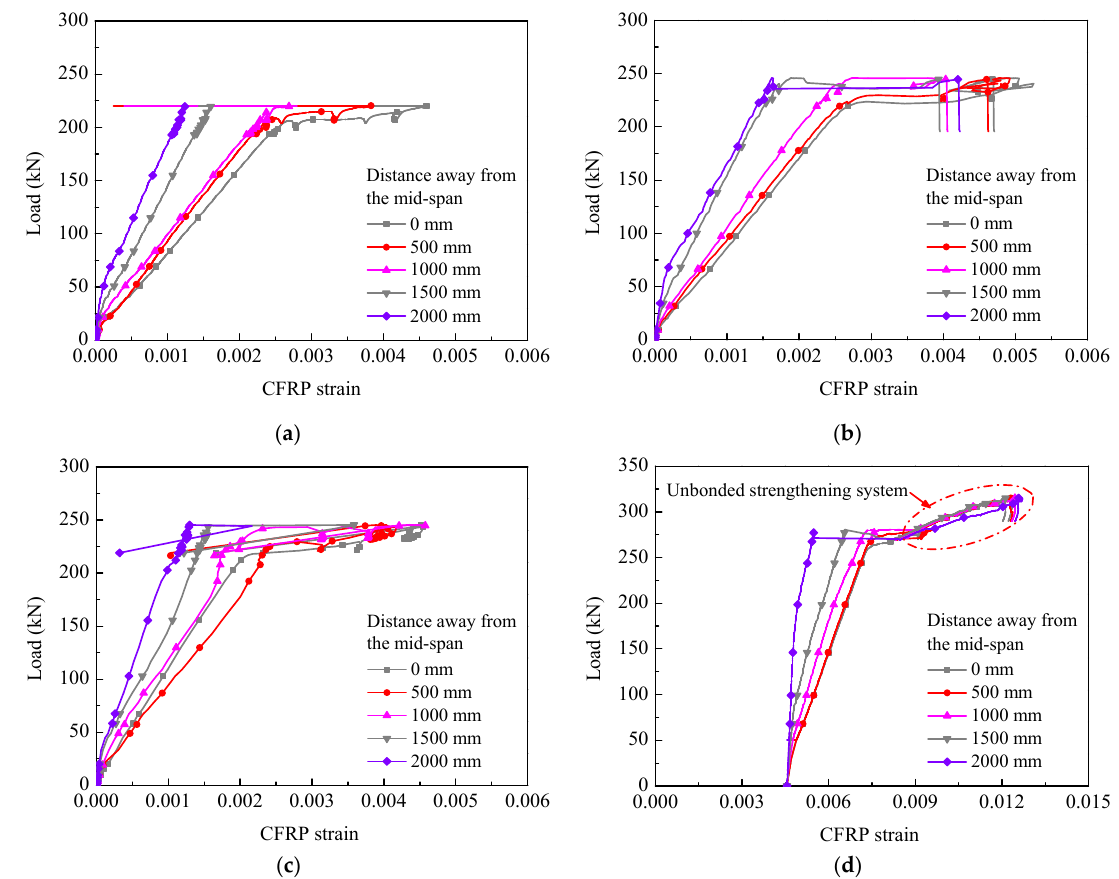
Figure 12. Typical load–CFRP strain curves: ( a ) BS-1, ( b ) BS-2, ( c ) BS-4, and ( d ) BP-2.